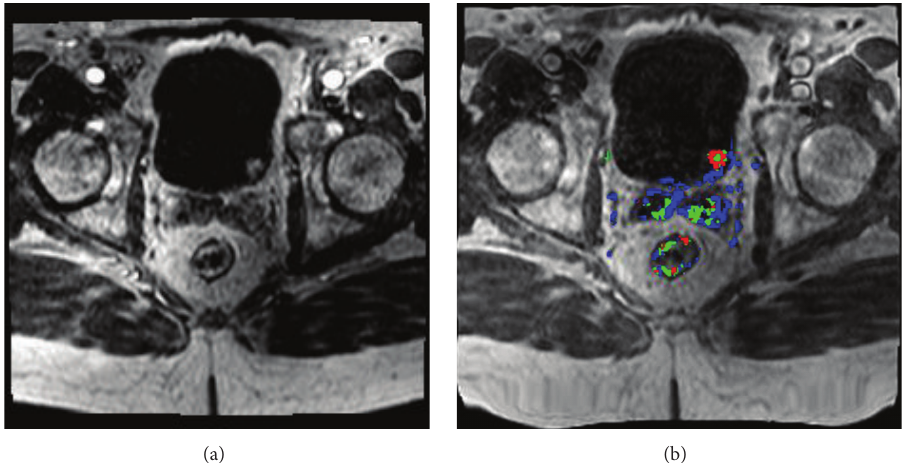
Figure 2: ((a) and (b)) Ax T1 dynamic contrast enhanced (DCE) images showing enhancement of the lesion with corresponding increased perfusion on postprocessing color overlay.